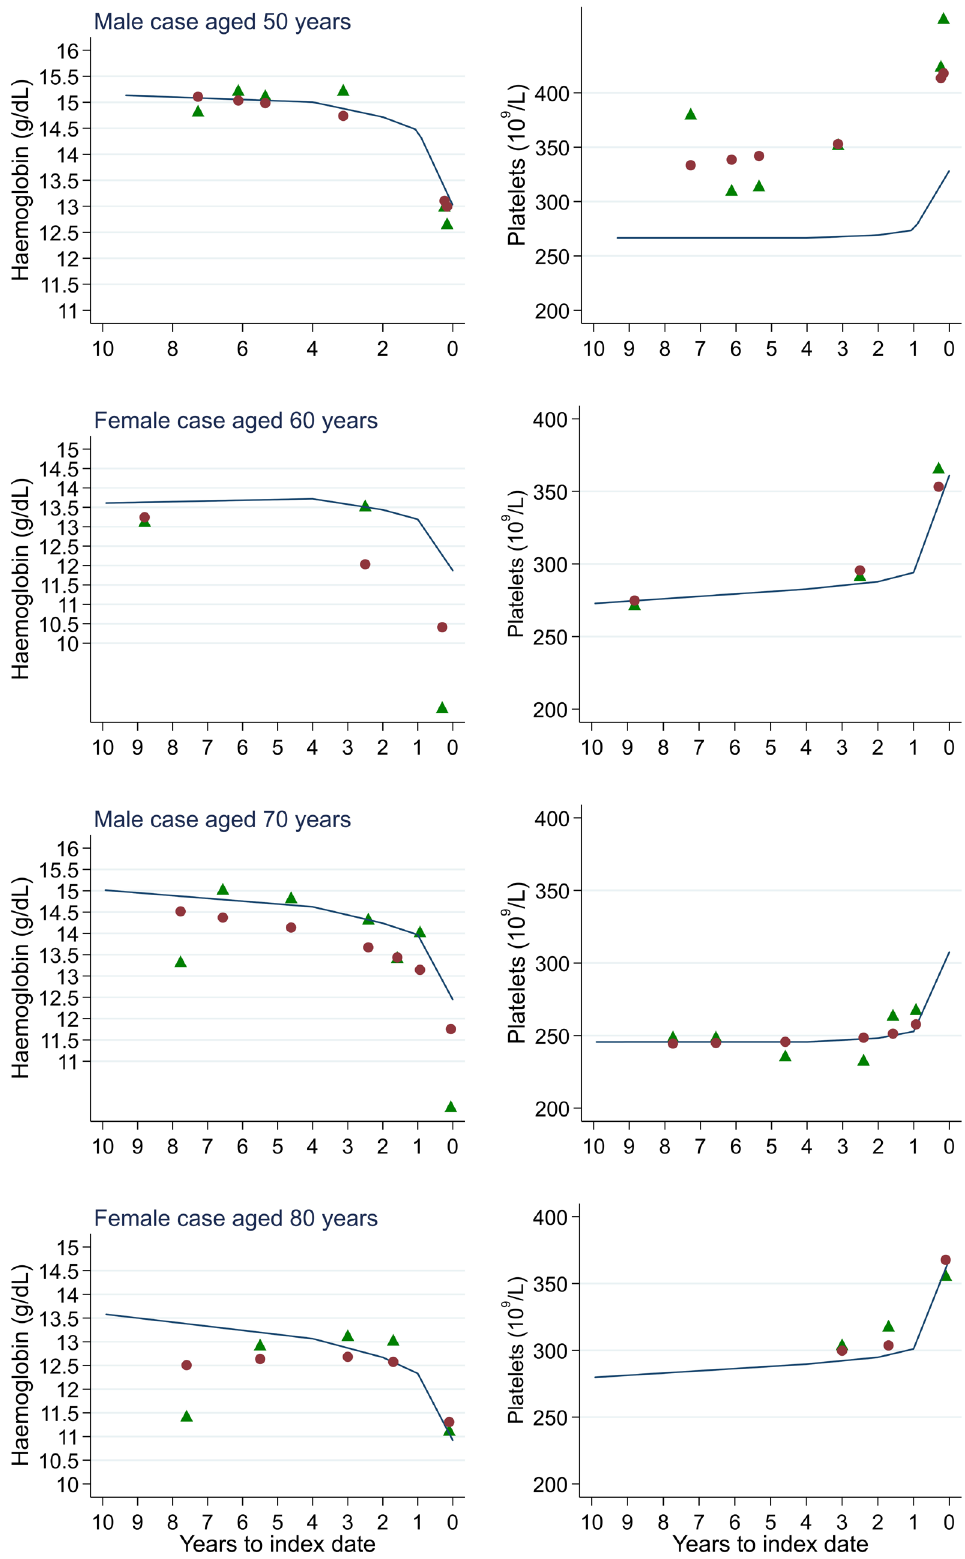
Figure 18. Individualised haemoglobin (left) and platelet (right) trends for four cases by age at index 1 . 1 Index date was the date of diagnosis for cases and a randomly selected date in the patient’s study period for controls. Legend: raw data (green triangle), modelled population-level trend (fixed effects) (blue line), modelled individualised patient-level trend (fixed and random effects) (red circle).